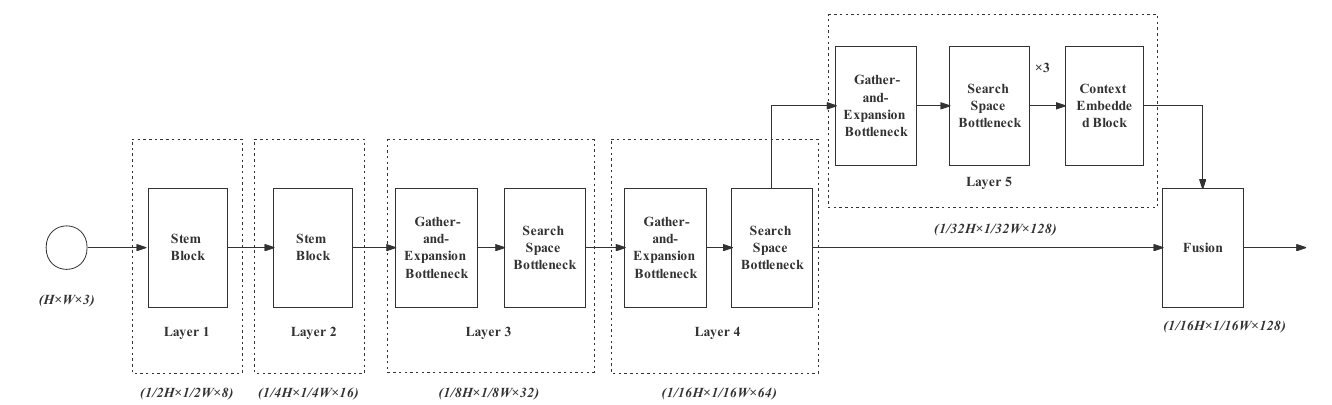
Figure 4. Semantic path. Notation: the (H × W × C) label beneath each layer denotes the layer’s output feature map height/width/channel; the search-space bottleneck in Layer 5 is repeated three times. Refer to Tables 1 and 2 for each layer’s detailed operations and